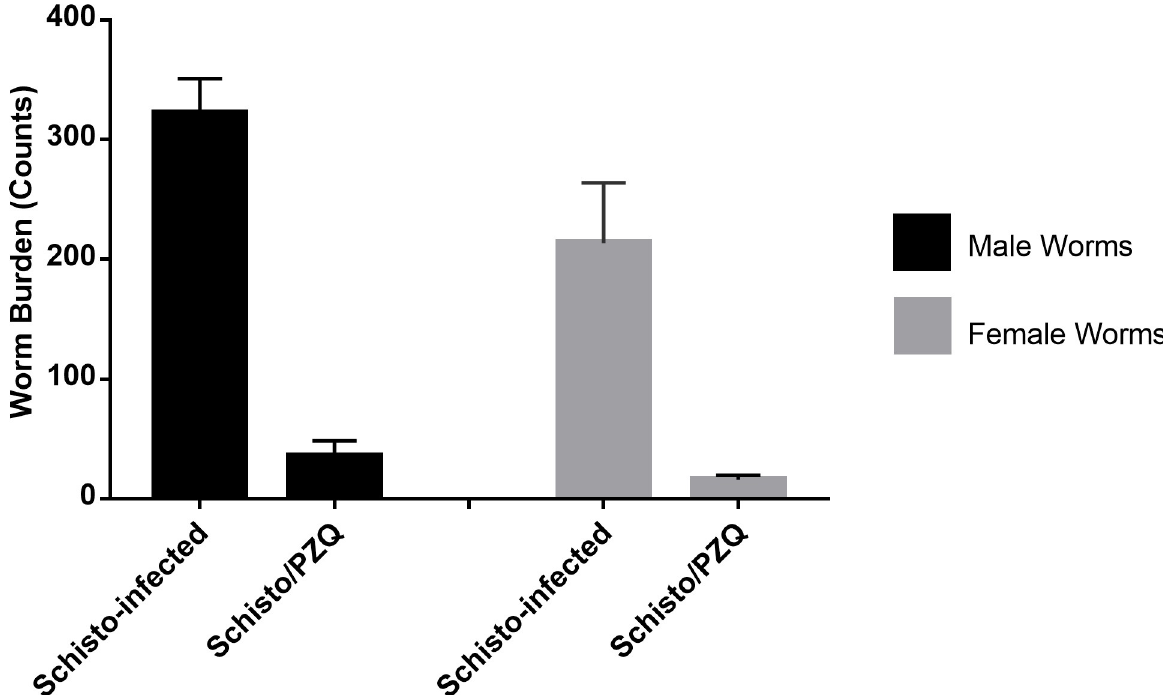
Fig 3. Adult Schistosoma worms recovered from the experimental animals. Total male worm counts, indicated by the black bar, and female worm counts, indicated by the grey bar, from the Schisto-infected and Schisto/PZQ animal